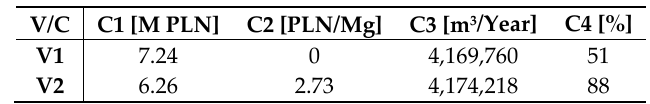
Table 1. Decision table.